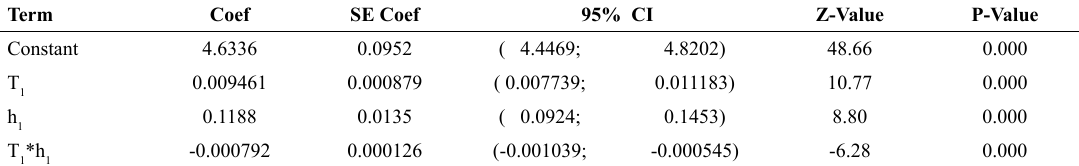
Table 10. Regression coefficients of flexural model with significant